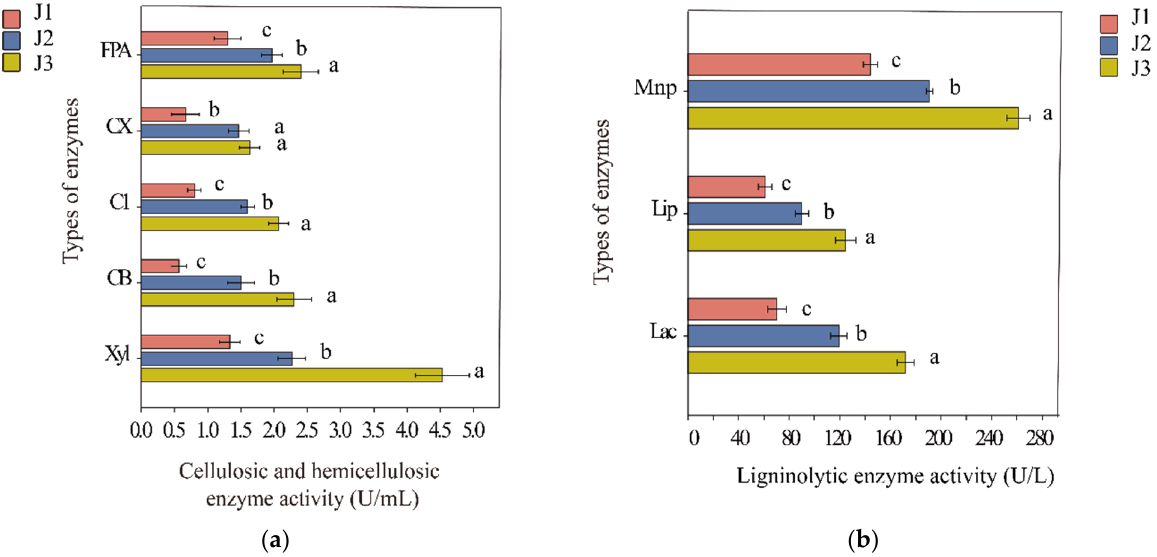
Figure 3. Lignocellulase activity of the tested bacterial agents. Cellulosic and hemicellulosic ( a ) and ligninolytic ( b ) enzyme activities of the tested bacterial agents. Different letters represent significant differences ( p < 0.05).